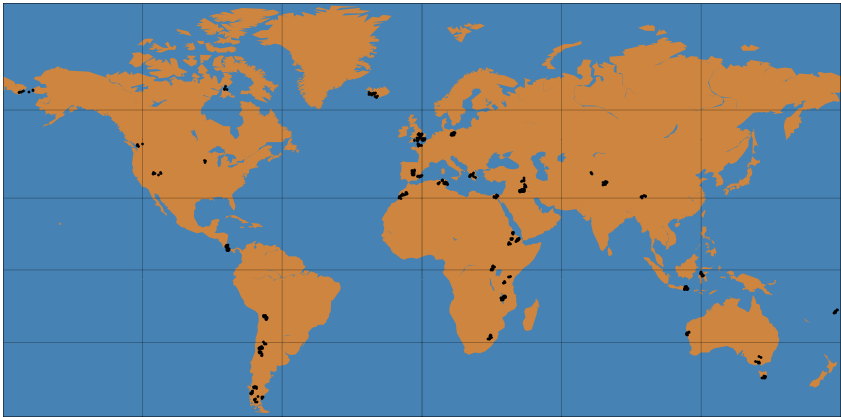
Figure 3. Geographical Overview of Selected